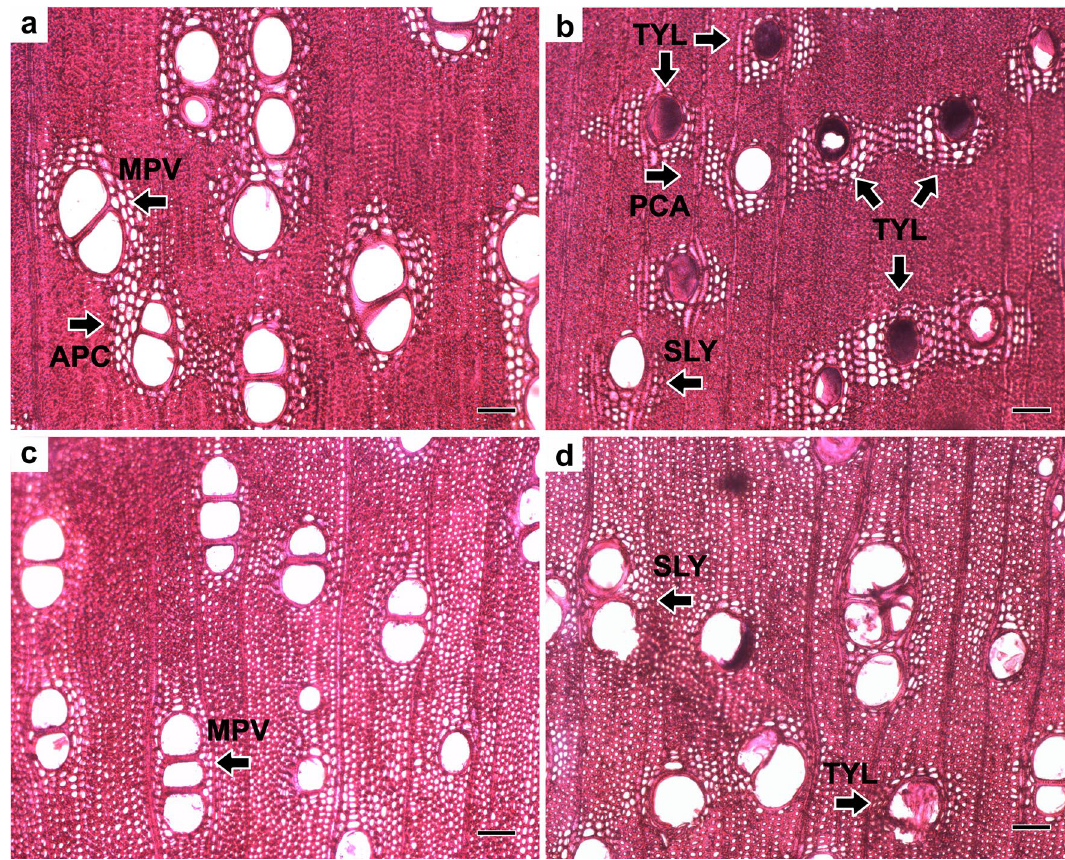
parenchyma confluent (APC); axial parenchyma confluent aliform (PCA). Scale bars = 100